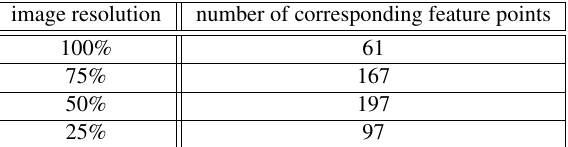
Table 2: Number of corresponding feature points with different image resolutions. Respective image examples Fig. 3 camera parameters. Outliers are detected and eliminated and all